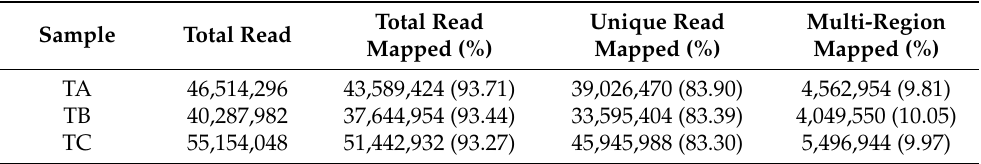
Table 5. Clean reads of RNA-Seq mapped onto unigenes in three groups (i.e., TA, TB, and TC) of Mortierella alpina based on